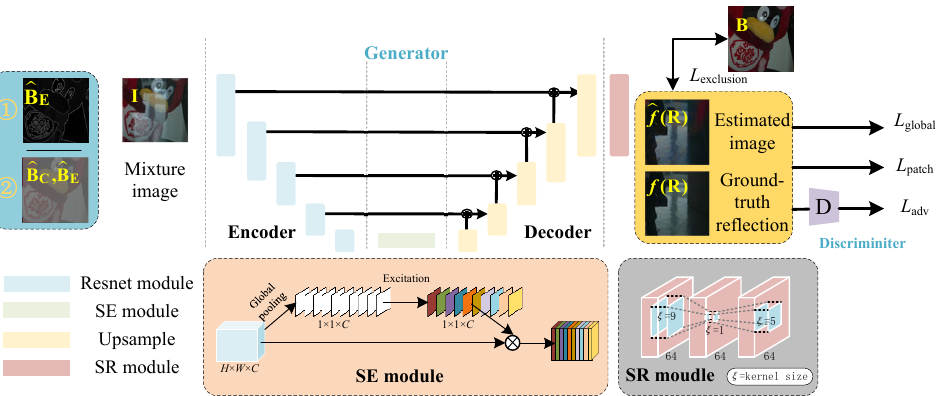
Figure 2. Flow diagram of the proposed method. The inputs contain two cases: (1) the estimated edge ˆB E and the mixture image I and (2) the estimated ˆB E , ˆB C , and the mixture image I